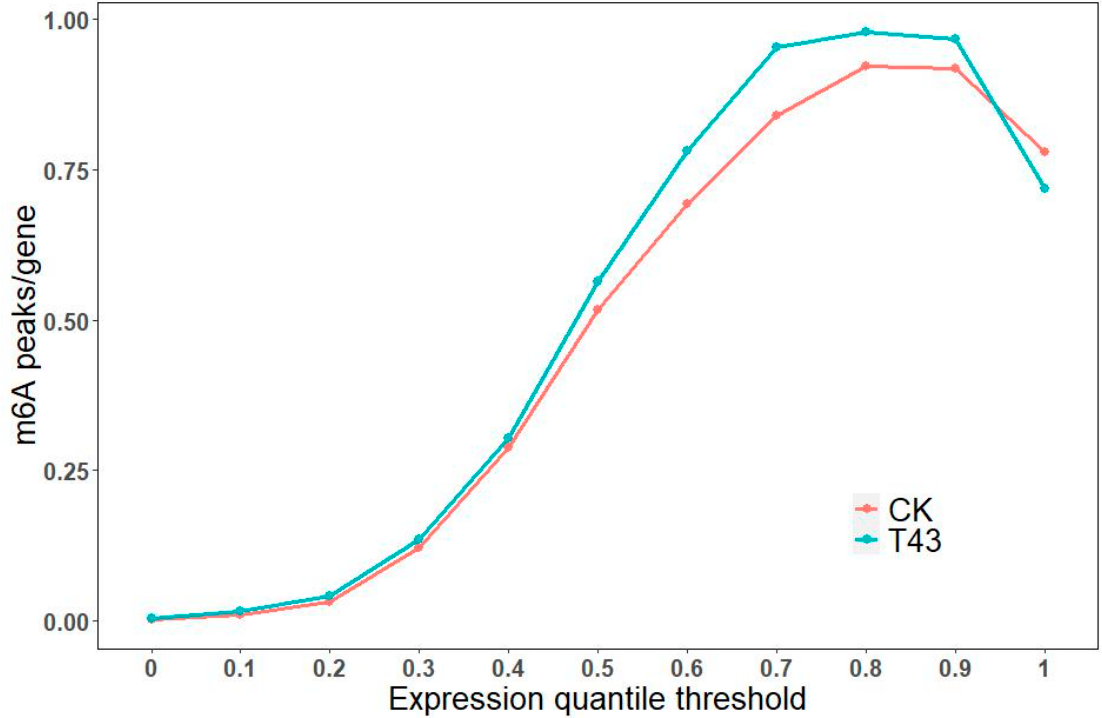
Figure 5. Estimation of m 6 A peaks density in Pak-choi transcripts.